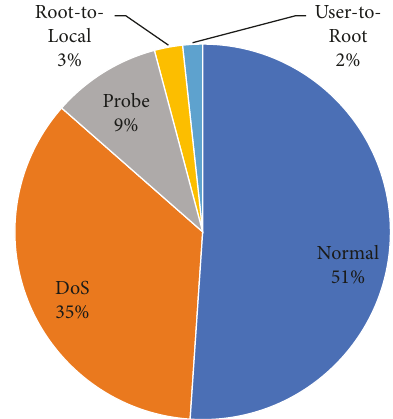
Figure 2: Pie chart of NSL-KDD dataset distribution.